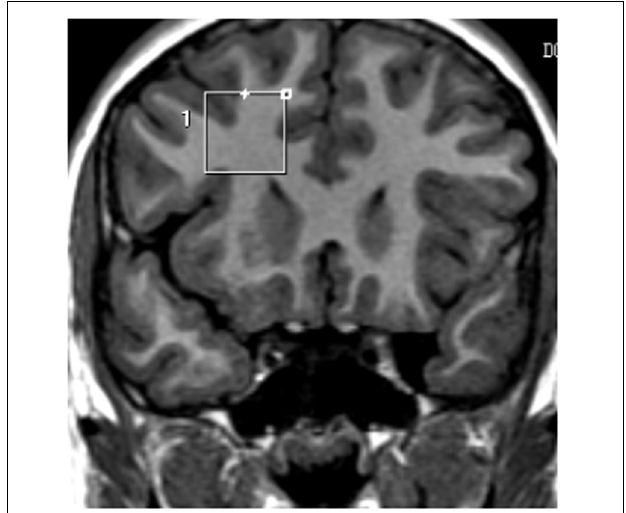
FIGURE 1 | Proton spectra was obtained from a voxel 2 × 2 × 2cm prescribed from a coronal plane. Four MRS VOI prescriptions were made for each child: two on the prefrontal white matter (right and left hemisphere) placing the VOI just ahead from the frontal horns of the lateral ventricles.